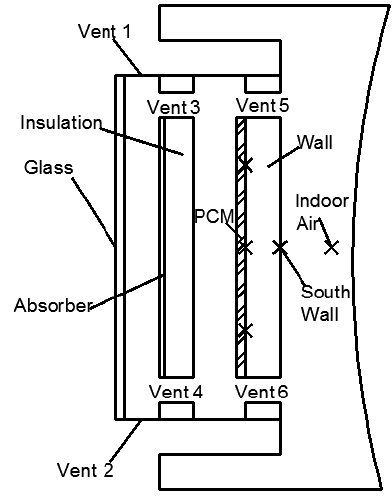
Figure 1. The structural diagram of the test setup.